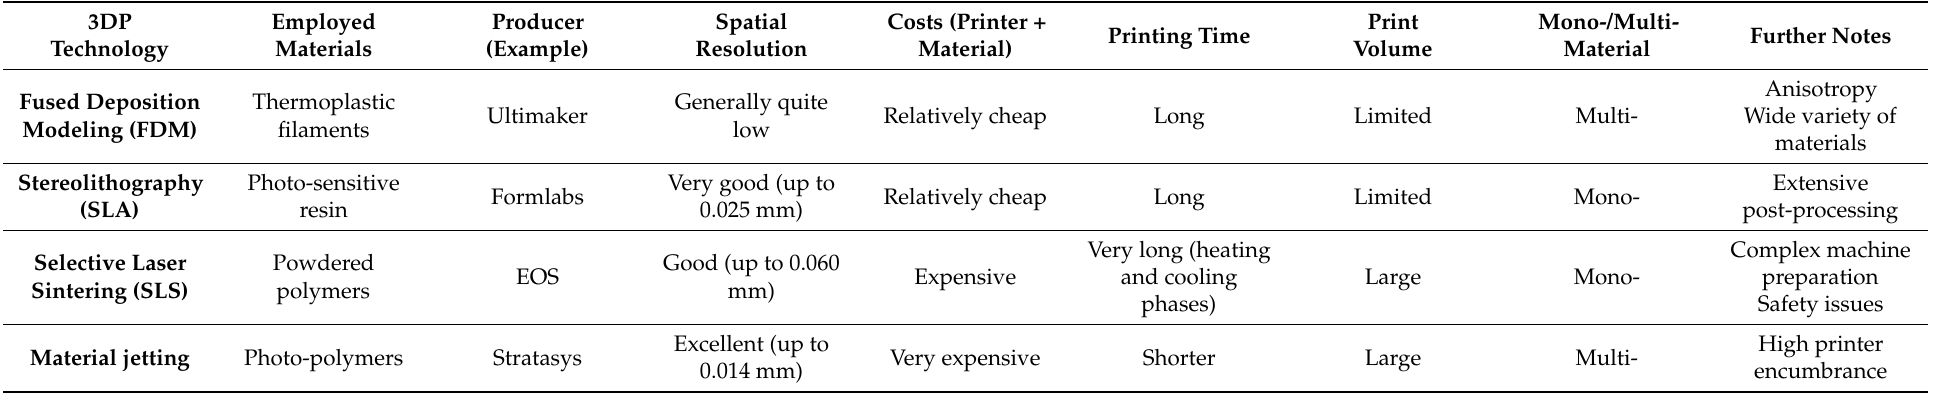
Table 1. Strengths and weaknesses of widespread printing technologies, potentially suitable for employment in cardiovascular